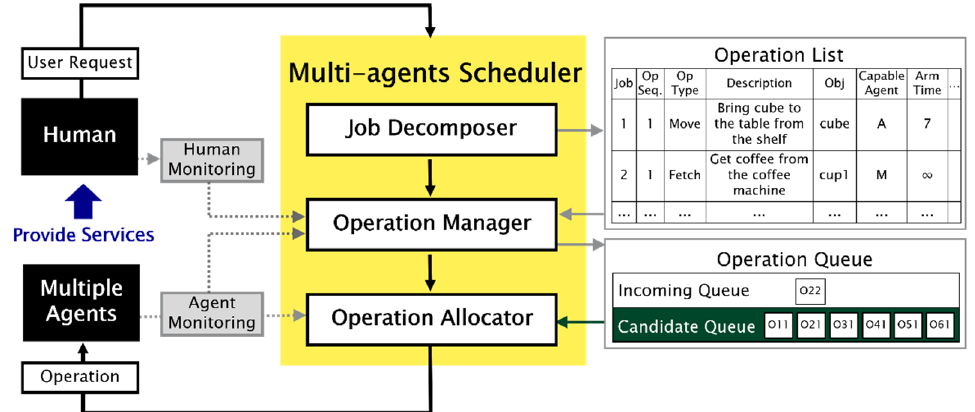
Figure 1. Diagram of the proposed scheduler framework.